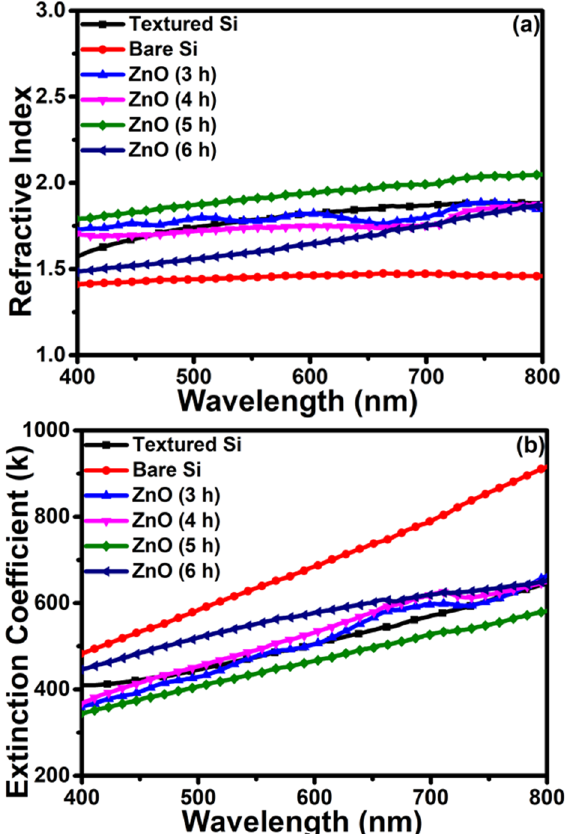
Figure 7. ( a ) Refractive index and ( b ) extinction coefficient plots of the bare Si wafer, textured Si wafer, and vertically arranged ZnO NRs on textured Si wafers.